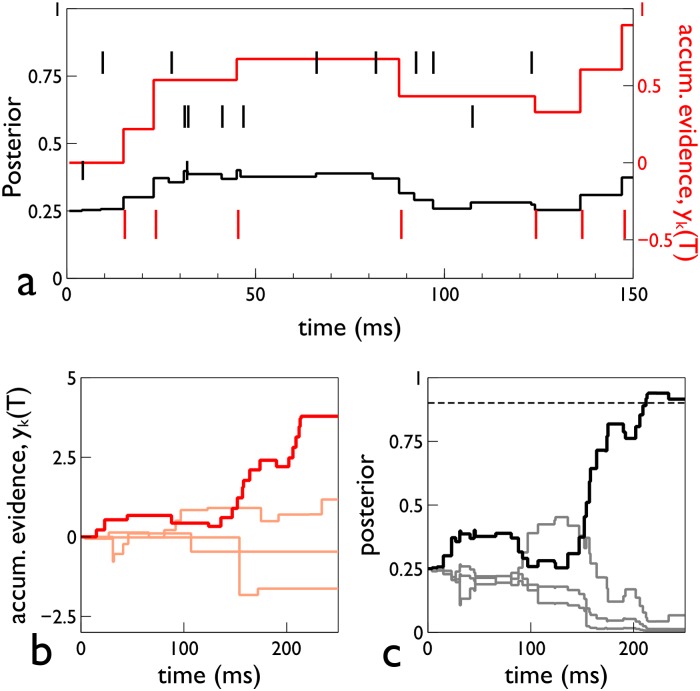
Time course of signals in a single trial of s-MSPRT.The trial is for an s-MSPRT using the gamma distribution, with 4 choices, under the parameterisation set ΩIV (see Methods). Panel a, shows the spike rasters of the 4 spike trains as small vertical line markers, with that of the preferred channel in red. This panel also shows the accumulated evidence y
k(T) as a red line graph. Panel b shows y
k(T) of all four hypotheses with the preferred hypothesis in bold red. Panel c shows the posteriors with the preferred hypothesis in black and the others in gray. The threshold is shown by the horizontal dashed line, and was chosen to give a 5% error rate.